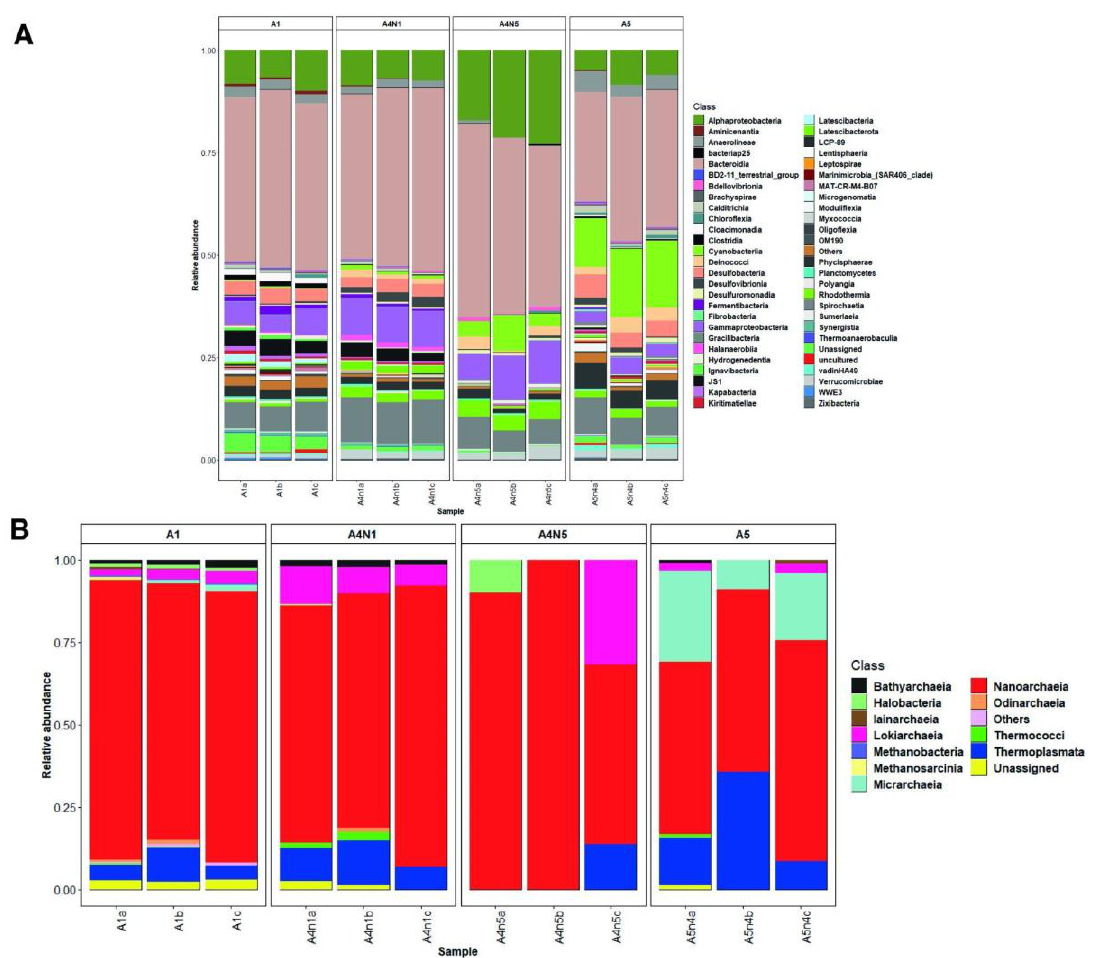
Figure 1. Stacked bar plots showing the relative abundances of bacterial ( A ) and archaeal ( B ) populations across all microbial mat samples at the class level. Taxa representing < 0.1% are grouped in “others”.